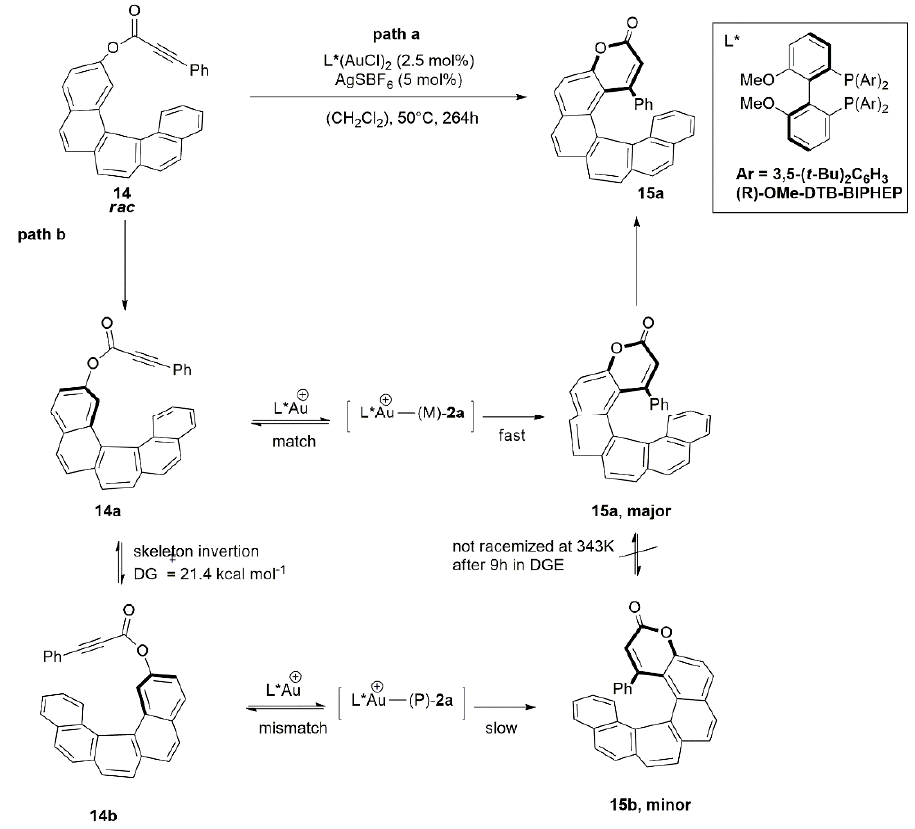
Figure 8. path ( a ) Enantioselective synthesis of 15a by the intramolecular hydroarylation of 14 ; path ( b ) Synthetic strategy for coumarin-fused helicene ( 15 ) via AuI-catalyzed intramolecular dynamic kinetic hydroarylation. DGDE = diethyleneglycoldibutylether.